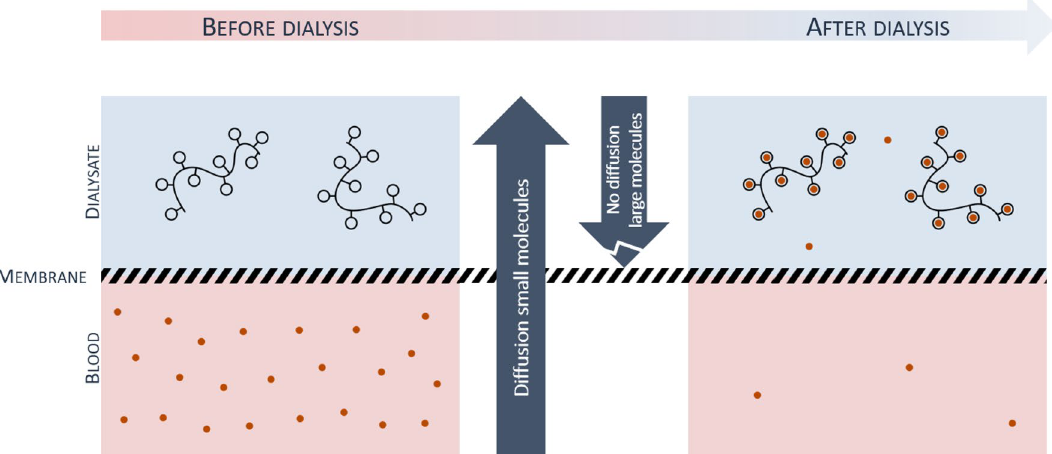
Figure 1. Principle of hemodialysis combined to chelating polymers for metallic extraction of the blood. During hemodialysis, chelating polymers cannot pass through the dialysis membrane in comparison with